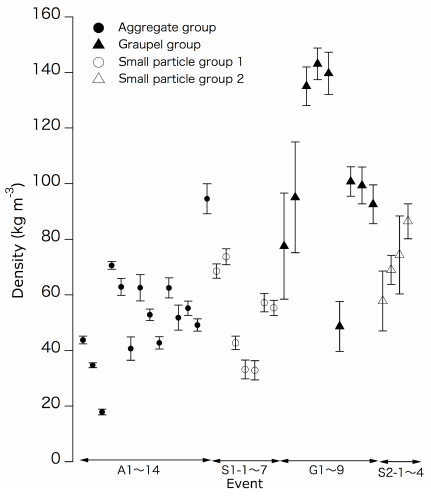
Figure 5. Measured snowfall density of events in each classified group: aggregate (A) group (filled circles), graupel (G) group (filled triangles), small particle group 1 (S1) (empty circle), small particle group 2 (S2) (empty triangle). The error bars indicate reading errors.